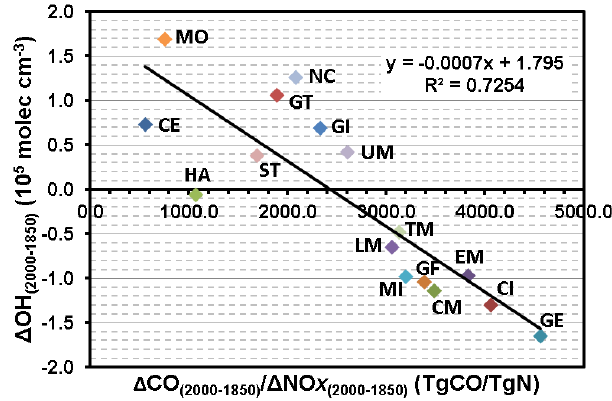
Fig. 4. Scatterplot of absolute change in annual average tro- pospheric mean OH concentration from preindustrial (1850) to present-day (2000) versus the ratio of absolute changes in annual average total tropospheric CO and NO x burdens for each of the 16 models. Each model data point is denoted by the first two letters of the model name shown in Table 1. Solid line corresponds to a linear regression of changes in OH with the ratio of changes in CO and NO x burdens. The regression equation is shown on the upper right corner of the